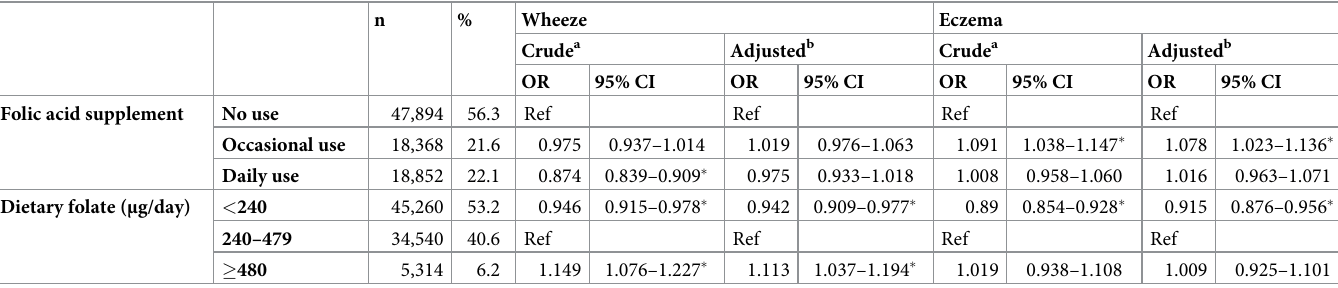
Table 3. Exposure to folic acid supplement or dietary folate and allergy.